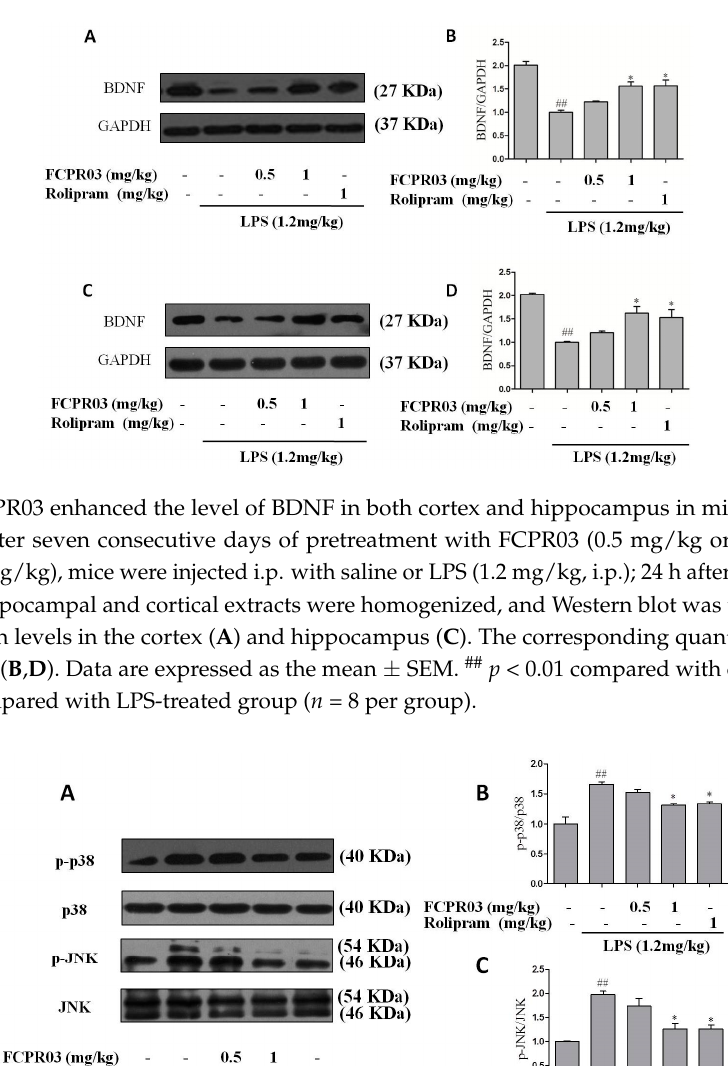
Figure 7. FCPR03 attenuated the phosphorylation of p38 and JNK in cortex in mice challenged with LPS. After seven consecutive days of pretreatment with FCPR03 (0.5 mg/kg or 1 mg/kg) or rolipram (1 mg/kg), mice were injected i.p. with saline or LPS (1.2 mg/kg, i.p.); 24 h after LPS injection, the entire cortical extracts were homogenized, and Western blot was used to assess the phosphorylated p38 (p-p38), total p38, phosphorylated JNK (p-JNK), and total JNK protein levels in the cortex ( A ). The corresponding quantification data are shown in ( B , C ). Data are expressed as the mean ± SEM. ## p < 0.01 compared with control group; * p < 0.05 compared with LPS-treated group ( n = 8 per group).